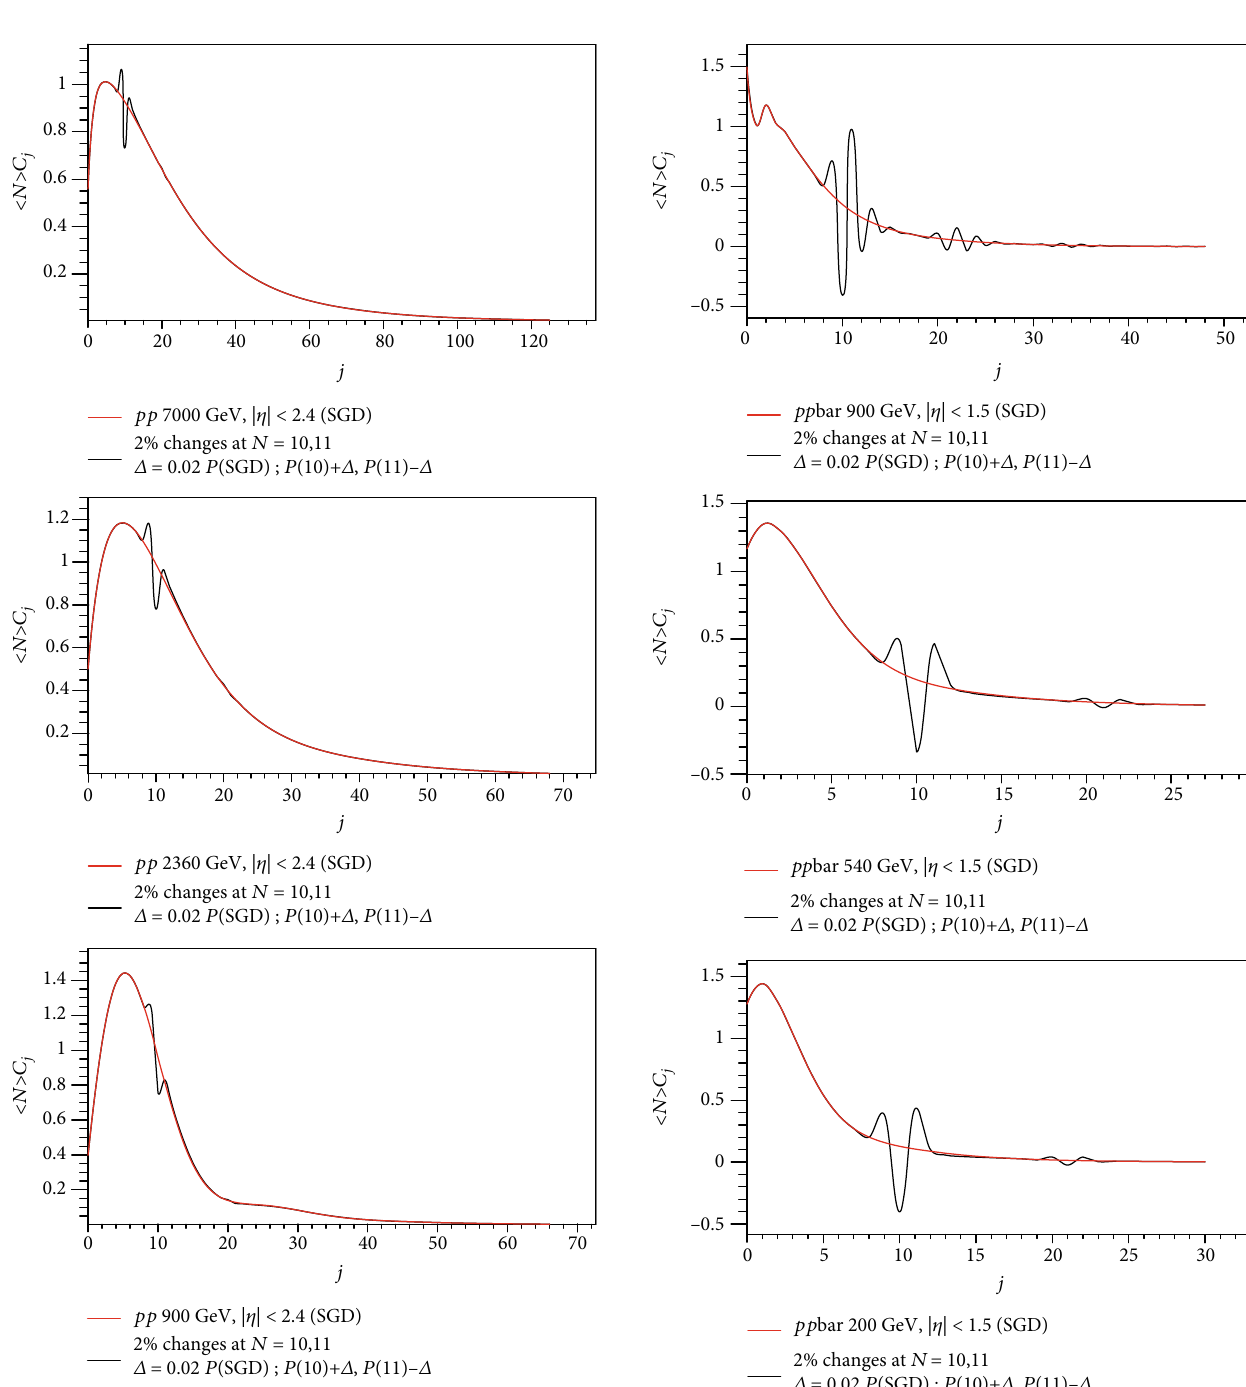
, Figure 13: Illustration of oscillatory behaviour of the coe ffi cients C j as described in the text.